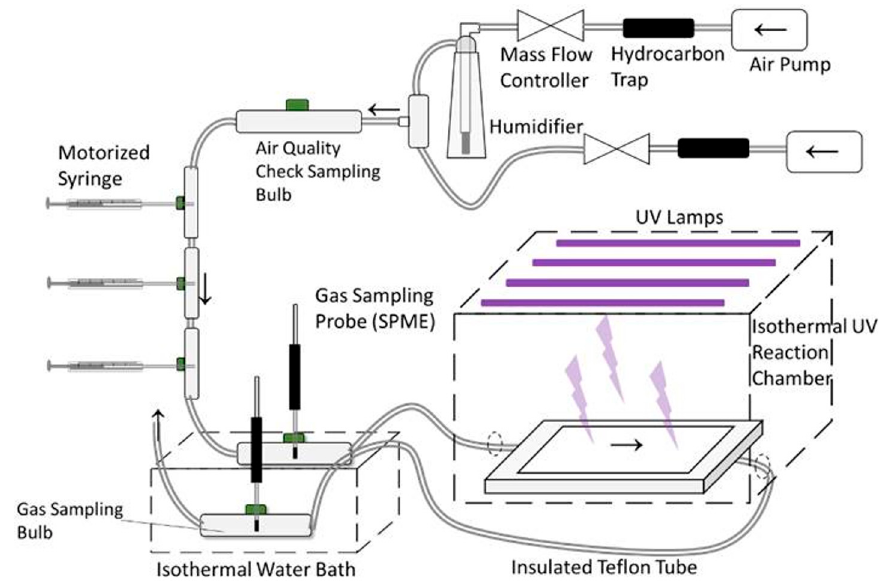
Figure 1. Schematic of a UV treatment system (ISU Air Quality Lab).